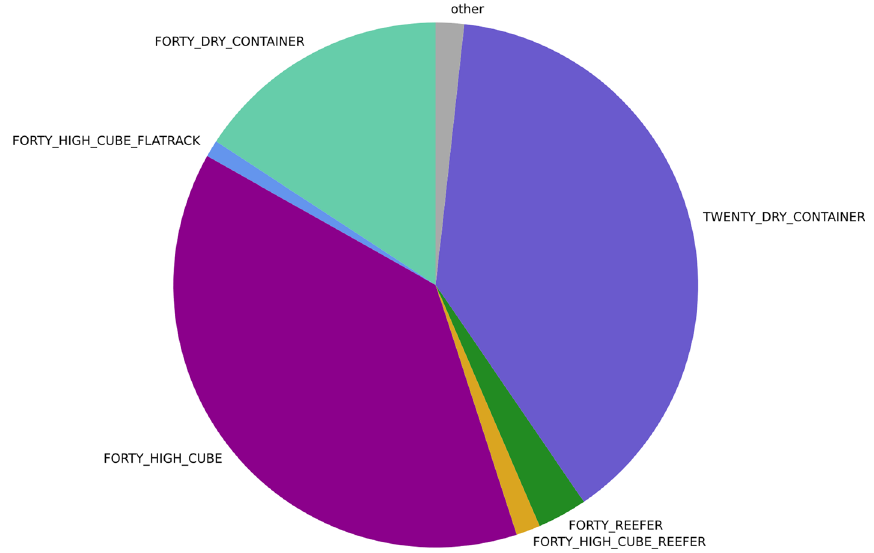
Fig. 5 Share of container types. Source : Own